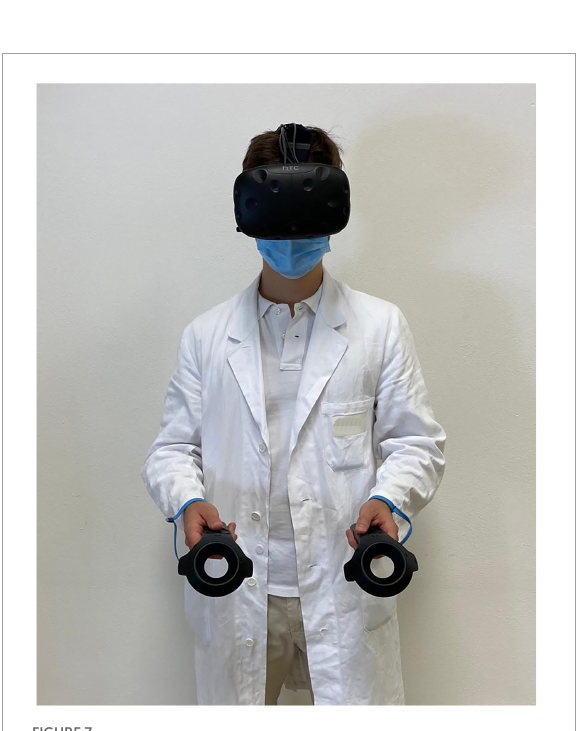
FIGURE7 An example of a subject wearing the virtual reality